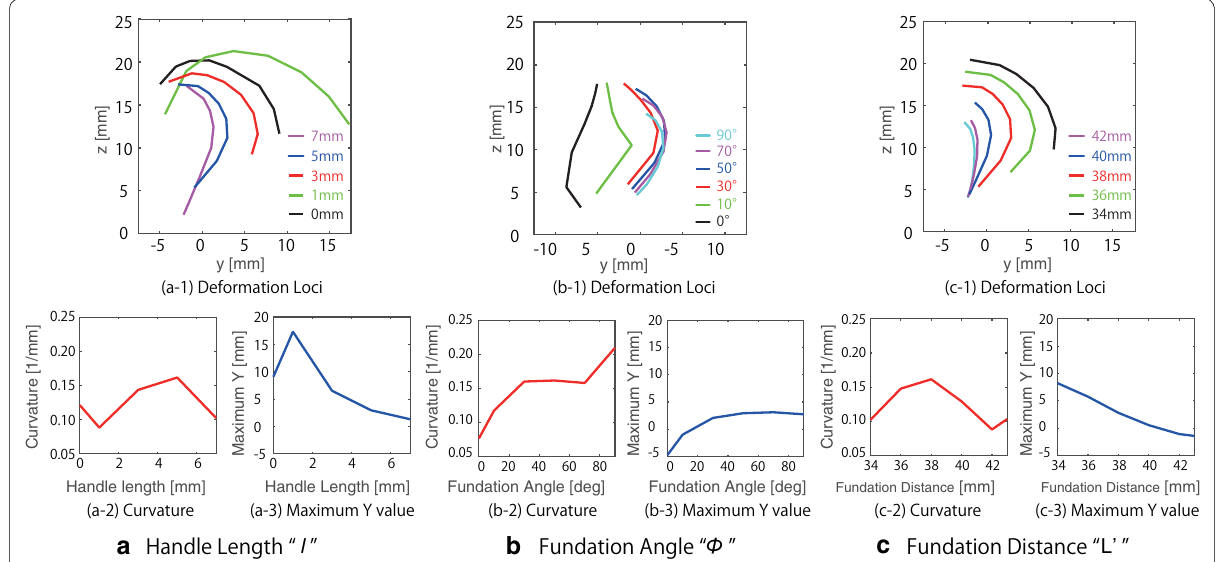
Fig. 6 Results from the calculation of the ELGM deformation. a with a black line in Fig. 5. a calculated with a least-squares approach. a